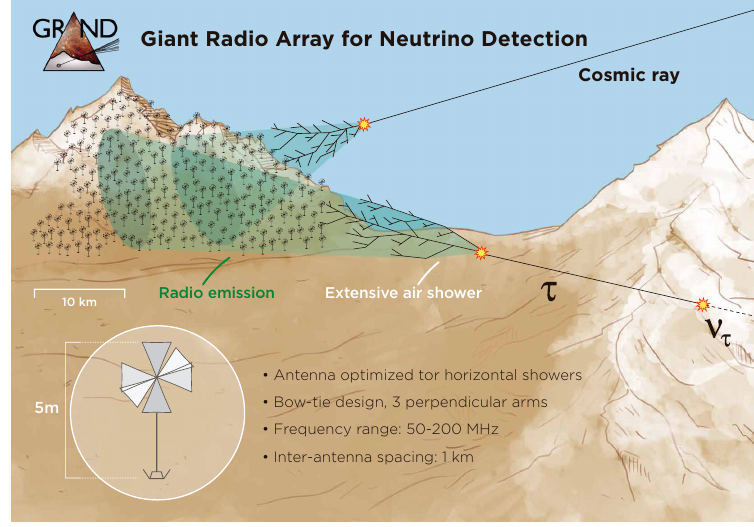
Figure 3: GRAND detection principle [ 1